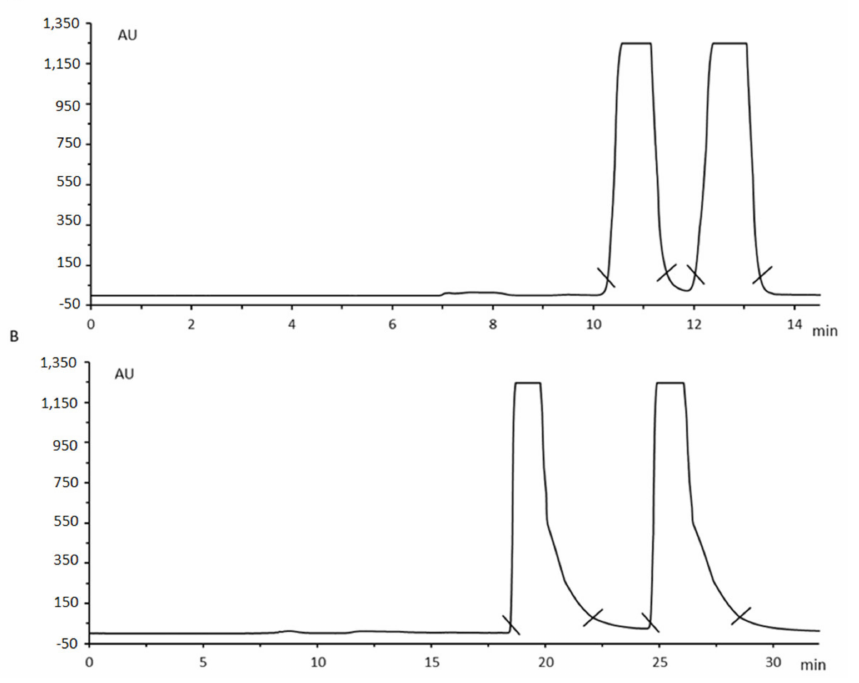
Figure 3. Liquid chromatography enantioseparation chromatogram of pentedrone ( A ) and methylone ( B ). Chromatographic conditions: Chiralpak ® AS-H column, mobile phase Hex / 2-PrOH (97:3, v / v )